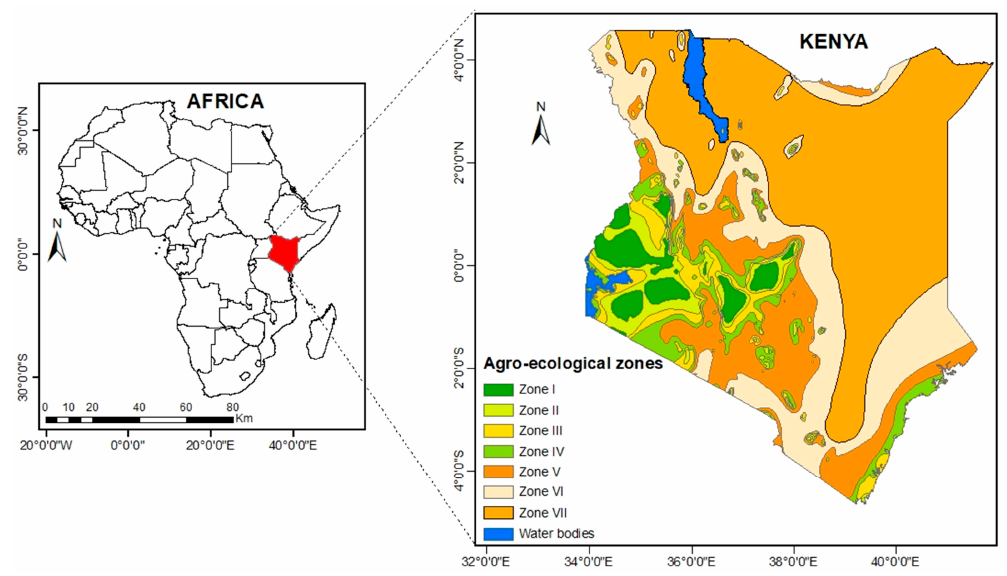
Figure 1. Location map of Kenya in Africa. The inset map shows the country’s seven agro-ecological zones.